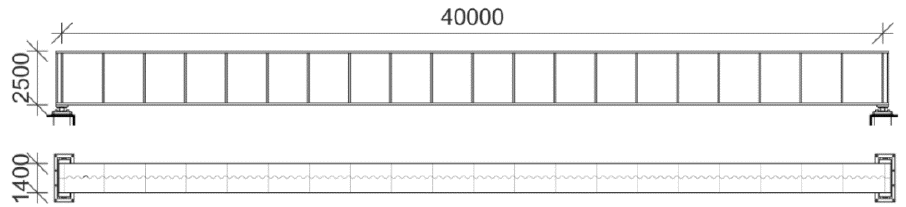
Figure 5. The layout of the girder in [mm].